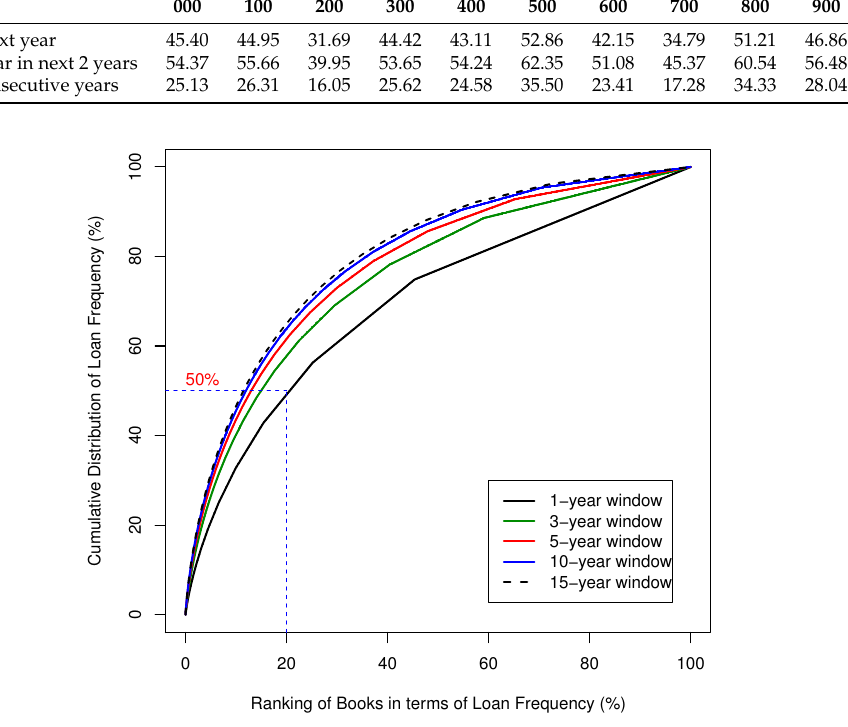
Figure 3. Cumulative distribution of loan frequency arranged in descending order with varying window